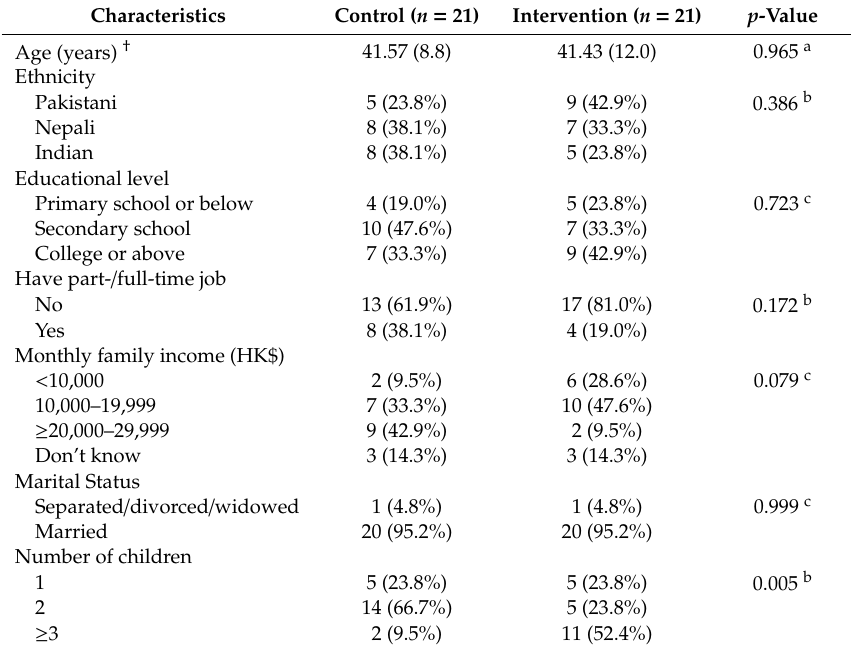
Table 1. Baseline characteristics of the participants ( n = 42).